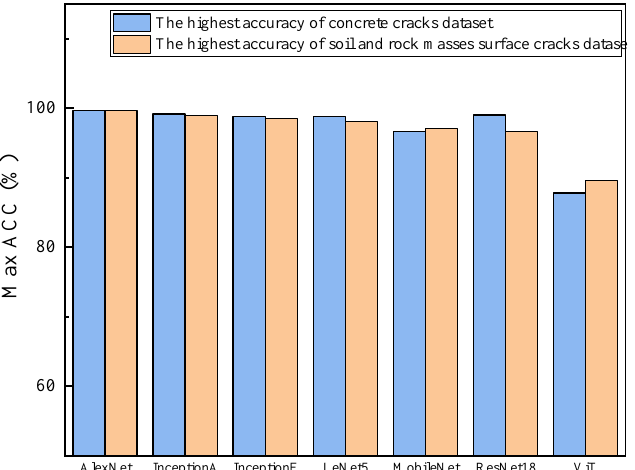
Figure 17. Comparison of the highest accuracy in the identification of surface cracks of soil and rock masses and concrete cracks of each